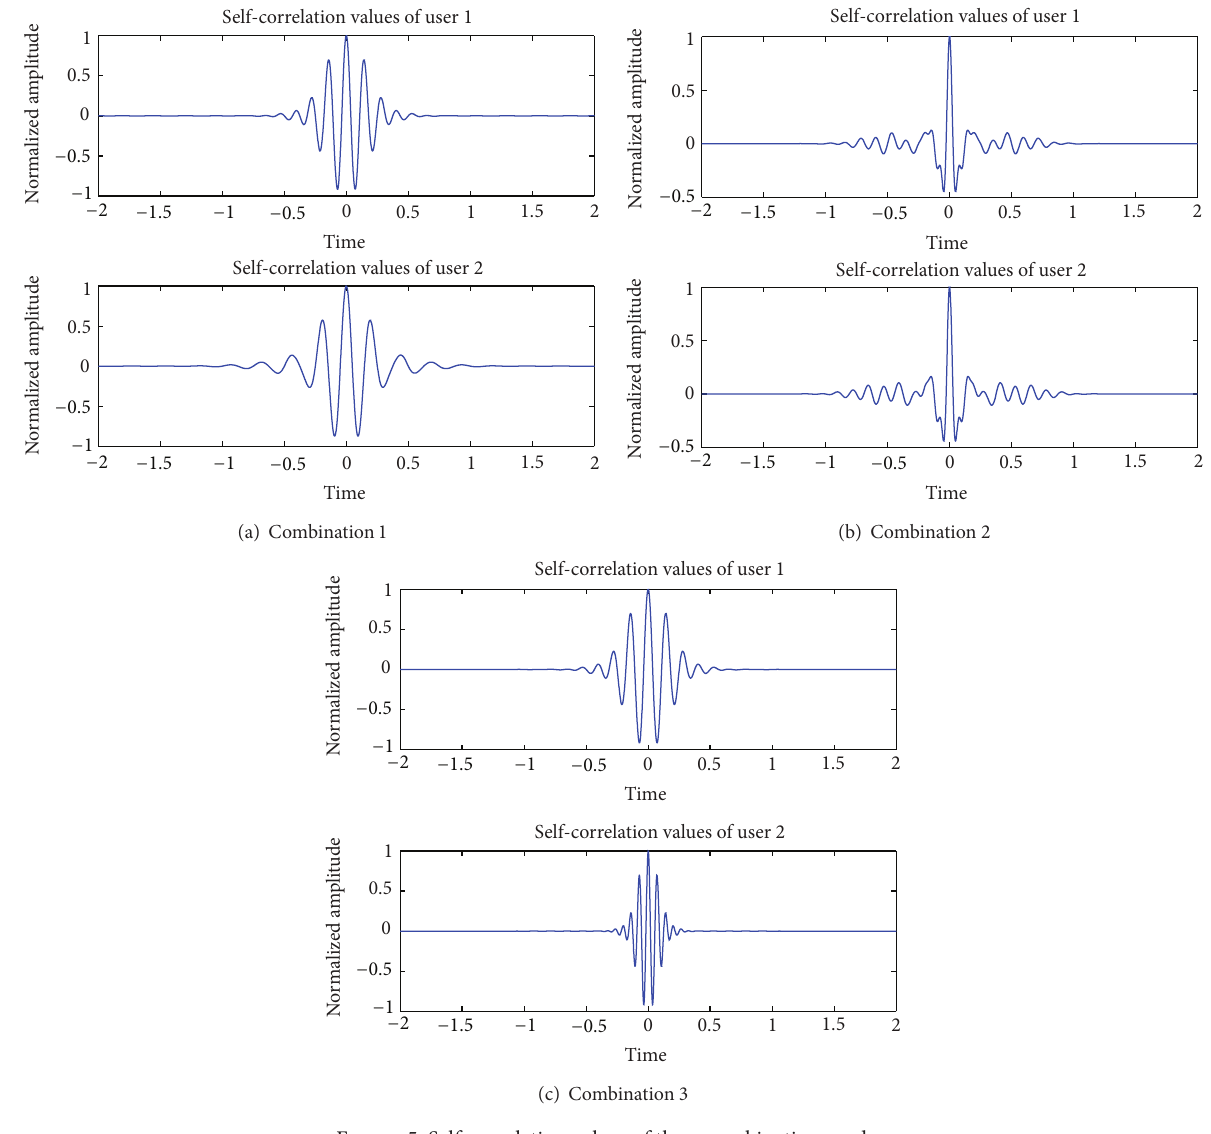
Figure 5: Self-correlation values of three combination